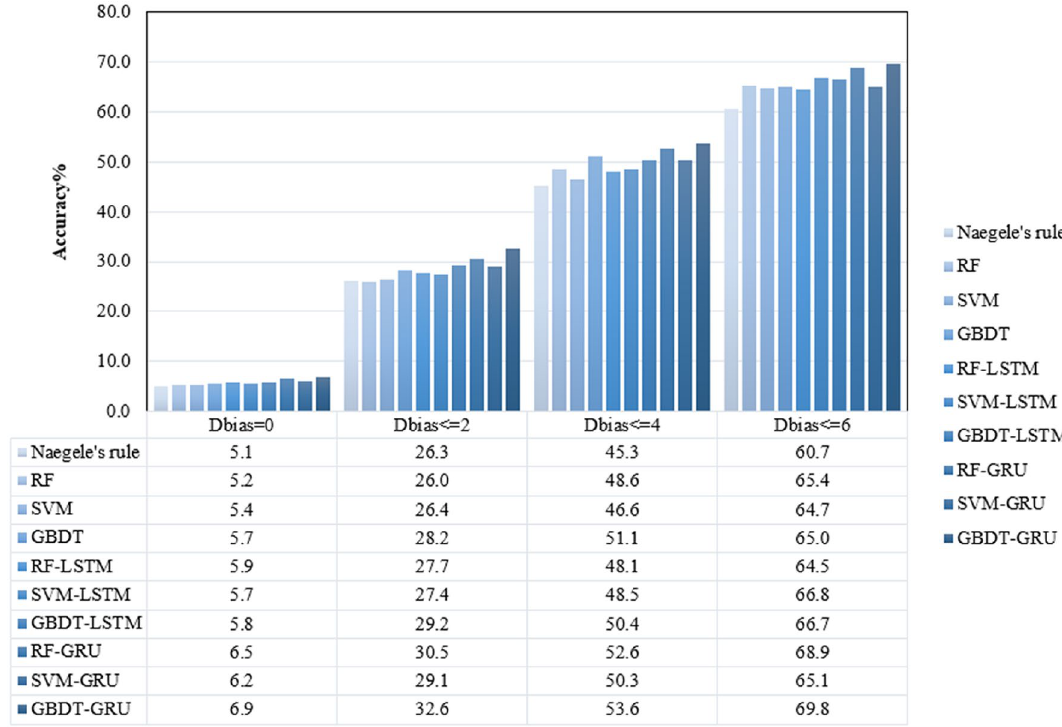
Figure 5. The accuracy of different methods under different D bias